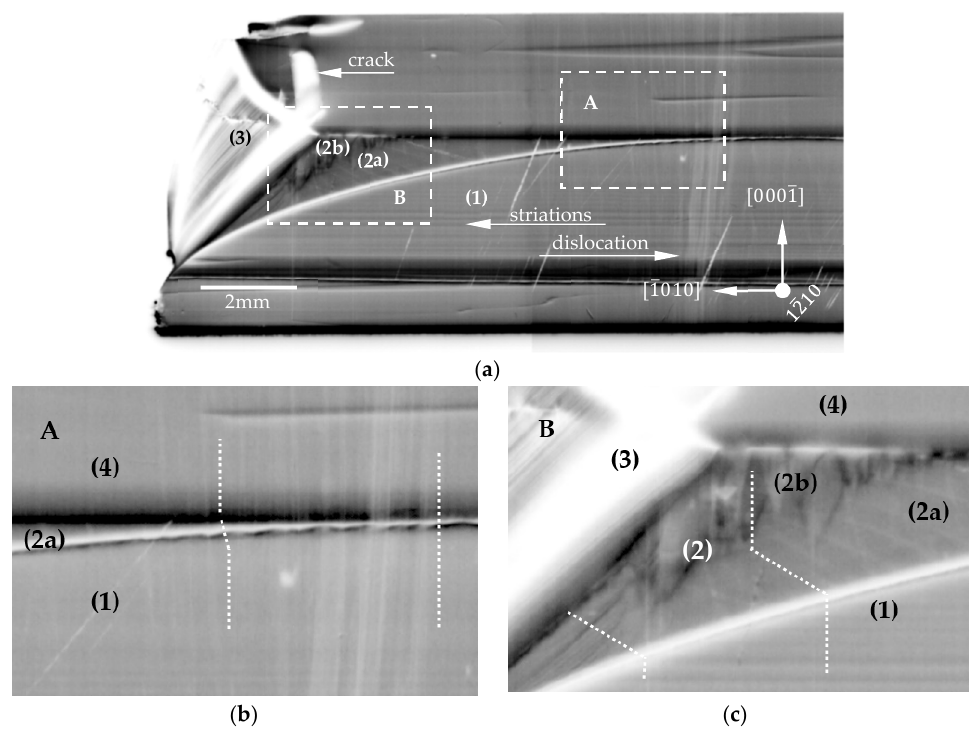
Figure 6. X-ray topographs of the 1210 slice. For the imaging, the 0002 reflection (Cu-K α 1 radiation) was used. ( a ) Overview topograph of the 1210 plane; five areas separated by clear interfaces were visible, as seen in Figure 3a,b; one crack was also present. Magnified images of sectors presented in Figure 6a: ( b ) sector A, where dislocations from area (1) went almost straight to area (4), and ( c ) sector B, with two-stage dislocation refraction in area (2) (considered as the sum of areas 2a and 2b) and one stage refraction from area (1) to (3).